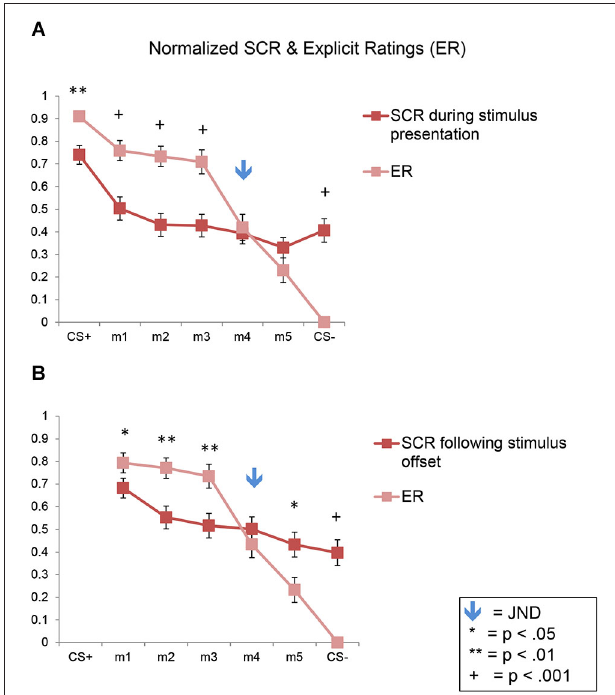
FIGURE 7 | Direct comparison of SCRs and ERs in normalized data . Line plots of the normalized SCRs and ratings data for the full sample ( n = 47). SCR data collected during the stimulus presentation are shown in (A) ; SCR data collected following stimulus offset are shown in (B) . Error bars represent one standard error from the mean. These plots show that conscious fear generalization, as reflected by the explicit shock likelihood ratings, was significantly greater than autonomic, SCR-based fear generalization. The flattening of the SCR plots here (compared to the plots in Figure 3 ) are due to the normalization process. SCR = skin conductance response; ER = explicit